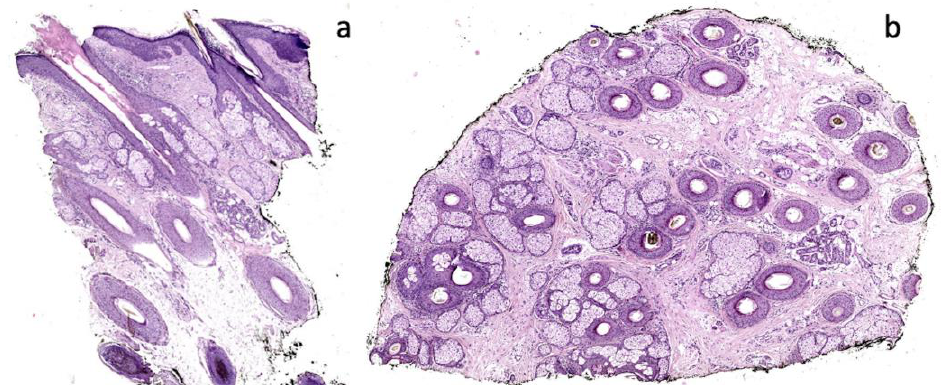
Figure 8. Histological findings typical of folliculitis and perifulliculitis (Patients 4 and 5). ( a ) 2× magnification, H&E and ( b ) 10× magnification, H&E.